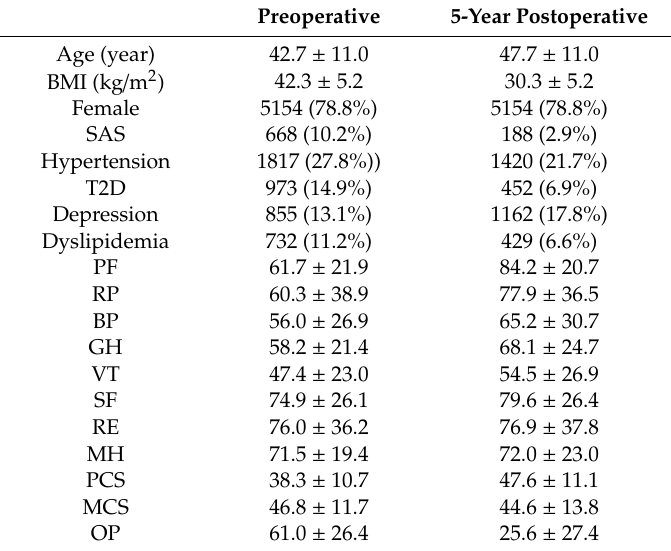
Table 1. Characteristics of the patients ( n = 6542) included in the study, mean ± SD or n